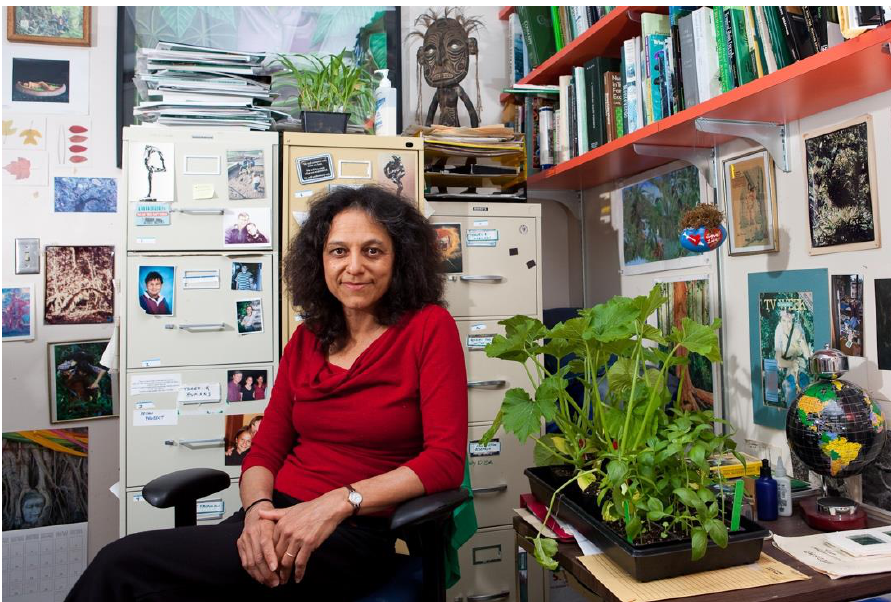
Figure 1. Nalini Nadkarni in her University of Utah office, where she is a professor of biology. Photo credit: Benj